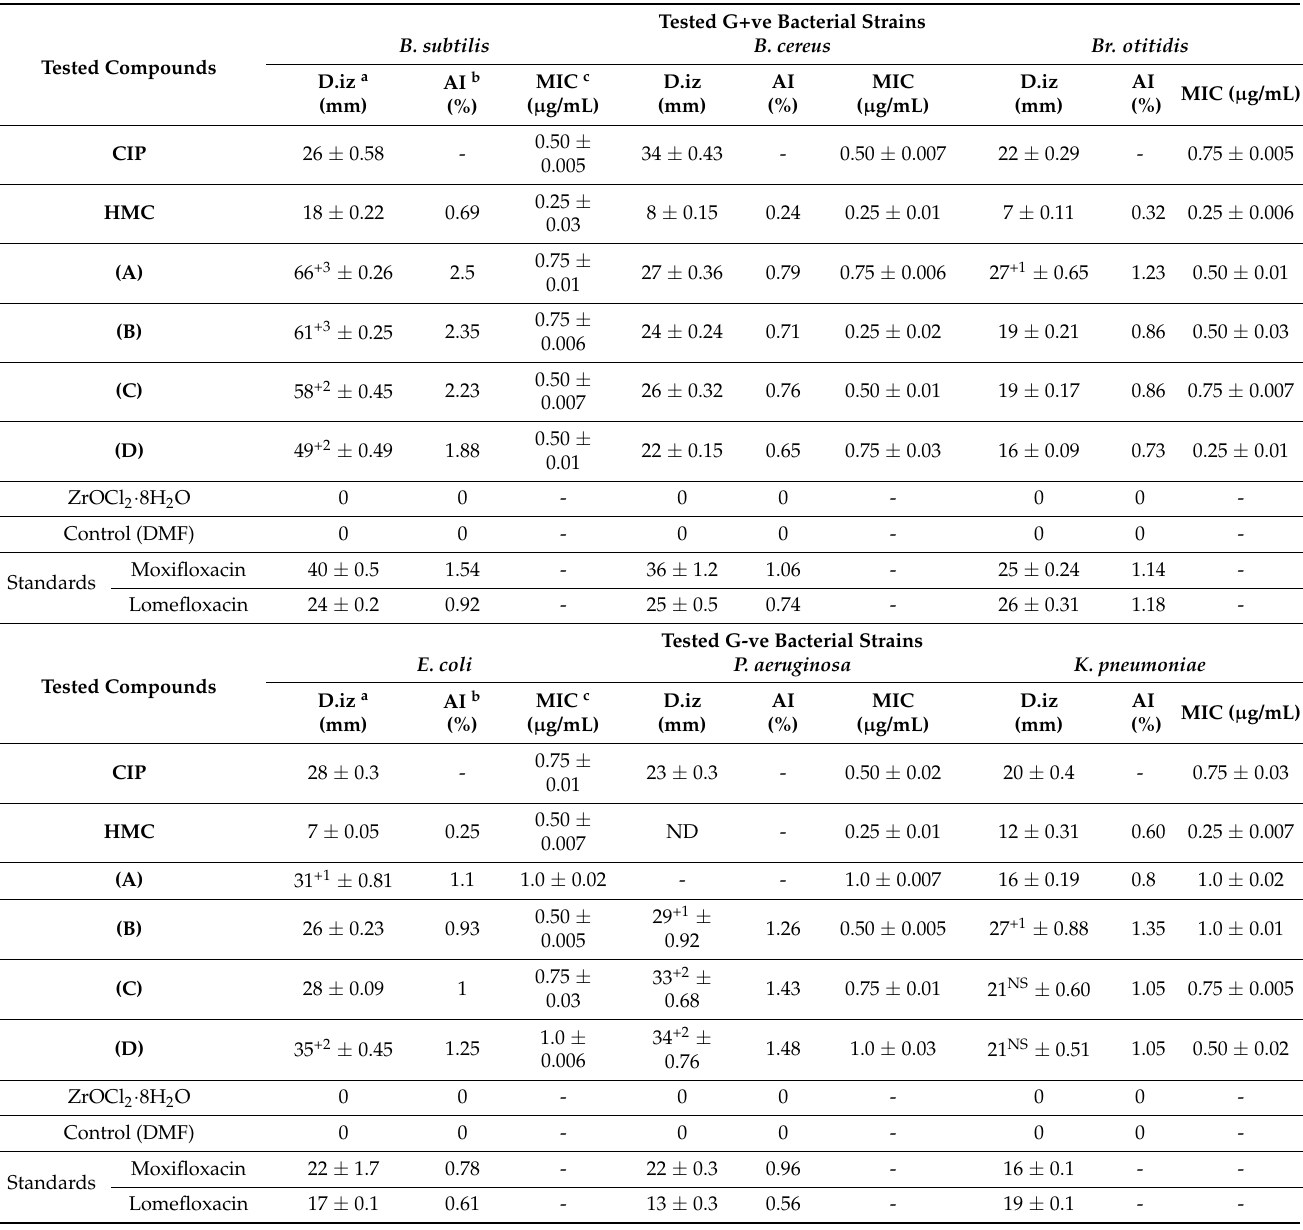
Table 7. Antibacterial activity of CIP, HMC, and their Zr(IV) complexes (A) , (B) , (C) , and (D) against G+ve and G-ve bacterial